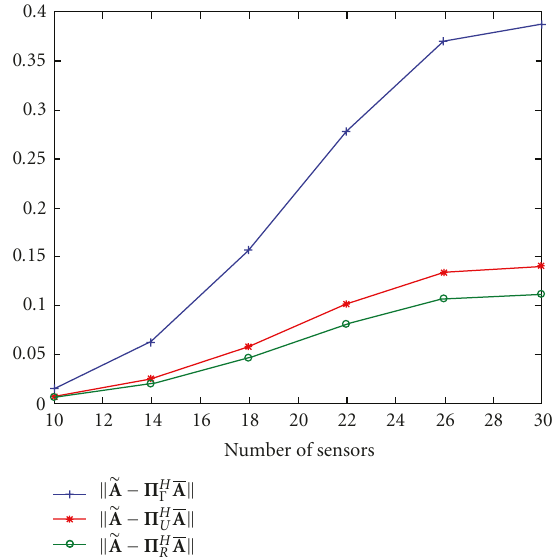
Figure 5: Error obtained with di ff erent propagator operators as a function of the number of sensors.